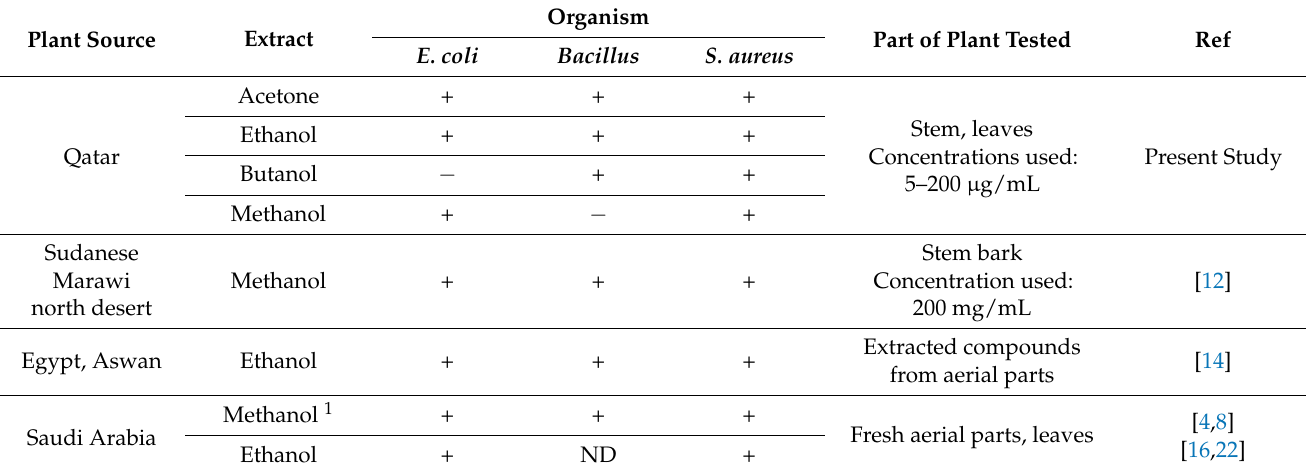
Table 3. The antibacterial activities of various extracts of Acacia ehrenbergiana growing in the desert environment: A